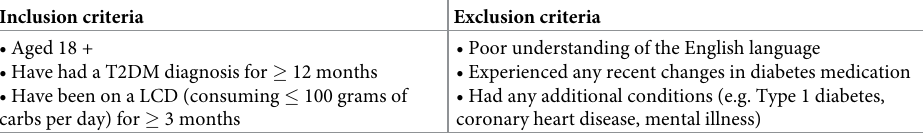
Table 2. Study inclusion and exclusion